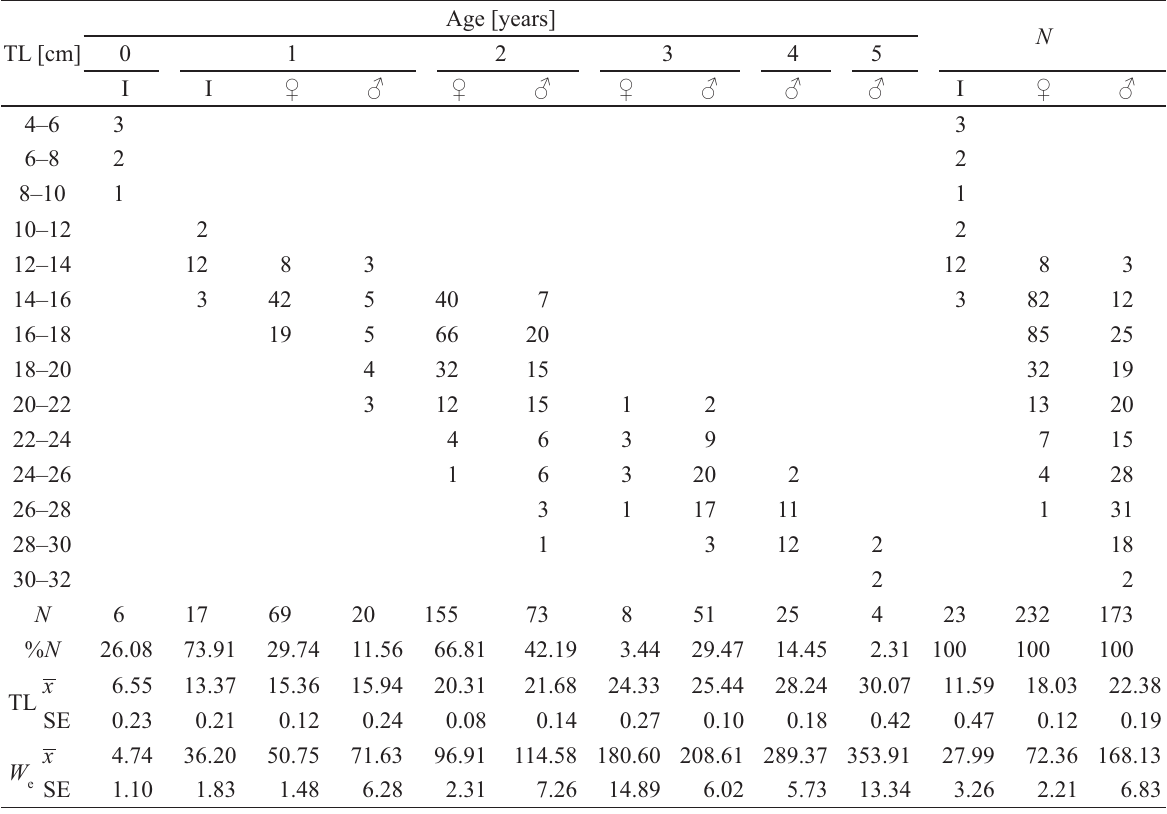
Age length key for females and males of peacock wrasse, Symphodus tinca , from eastern Algeria, based on scale readings